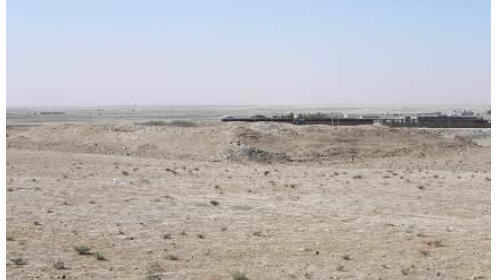
Figure 12 - Makhmúr al-Qadíma – CORONA (acquired on 16.8. 1968) with an overlaid objects of interest on the right